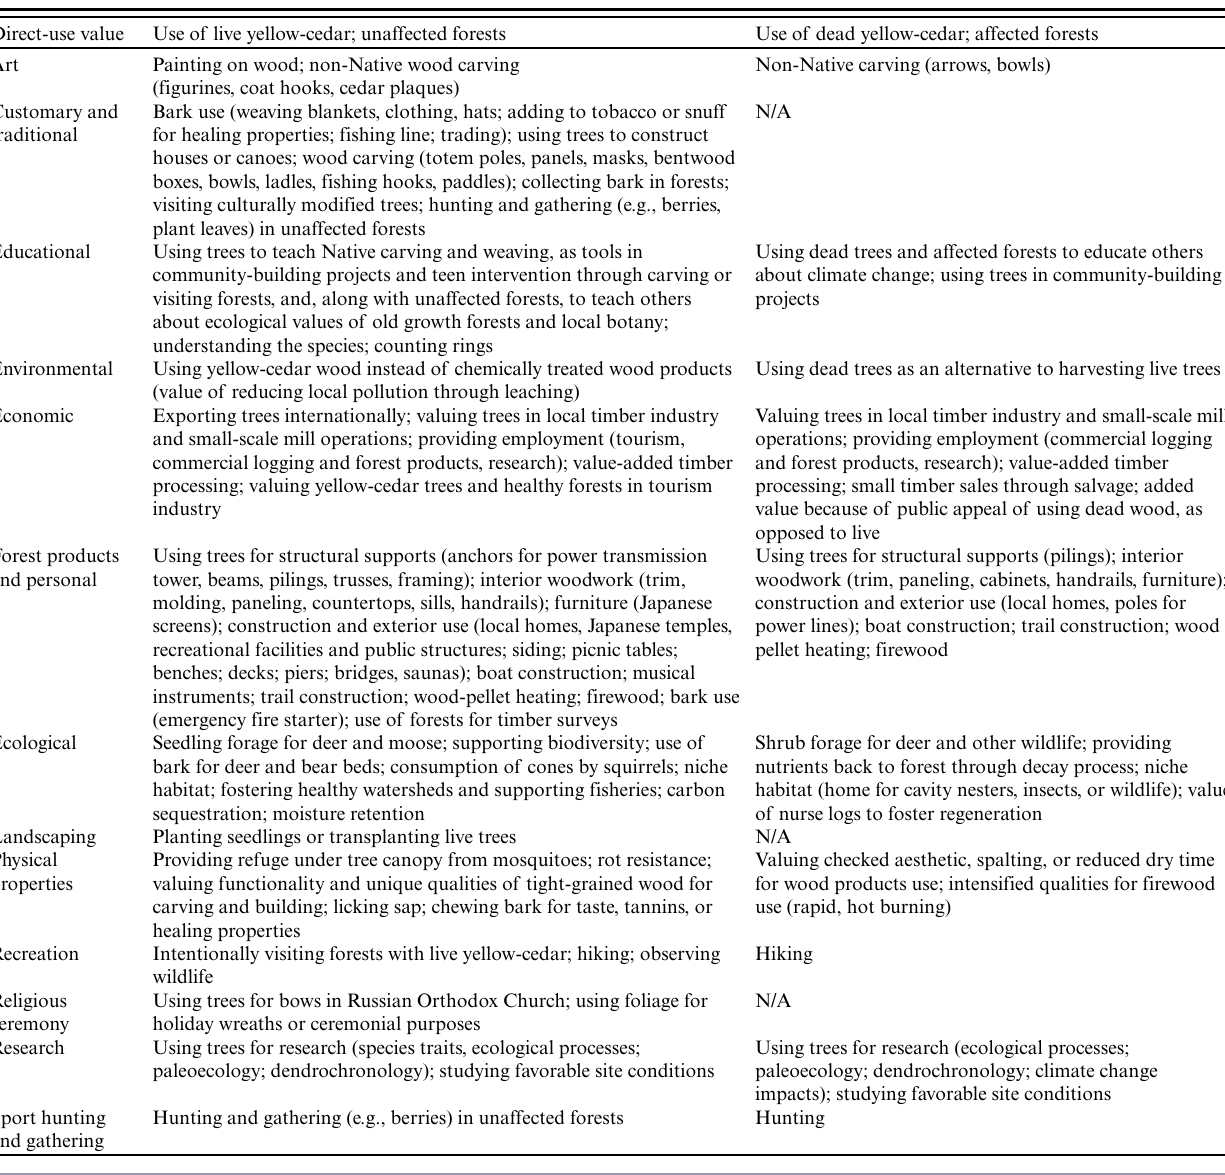
Table 4 . Reported direct-use values for live yellow-cedar trees and unaffected forests, as distinguished by study participants from dead yellow-cedar trees and affected forests. Use values listed are those reported that were discussed as past and present use values, not hypothetical future-use